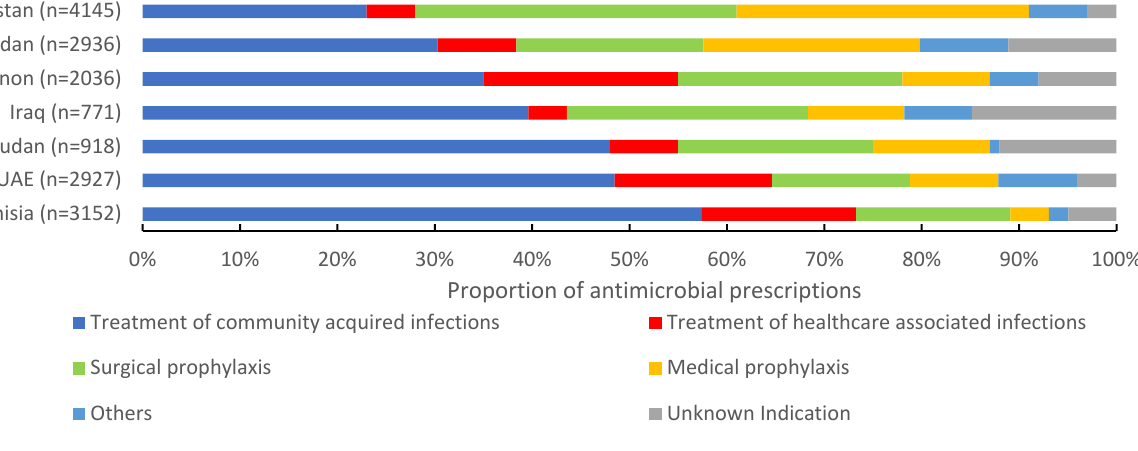
Figure 2. Indications of prescribed antimicrobials in 139 hospitals in seven countries in the Eastern Mediterranean Region, 2019 (n = 16,885). n = number of prescriptions.